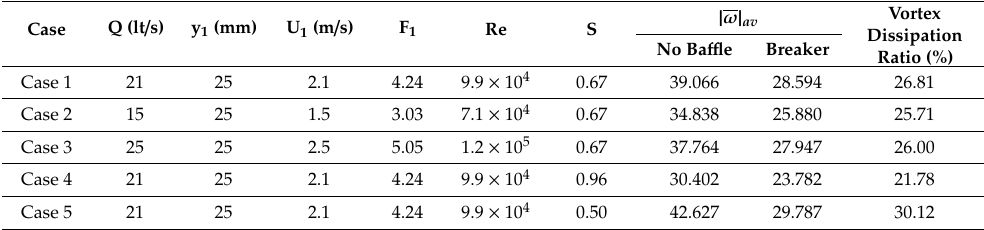
Table 6. Vortex breaker for di ff erent flow